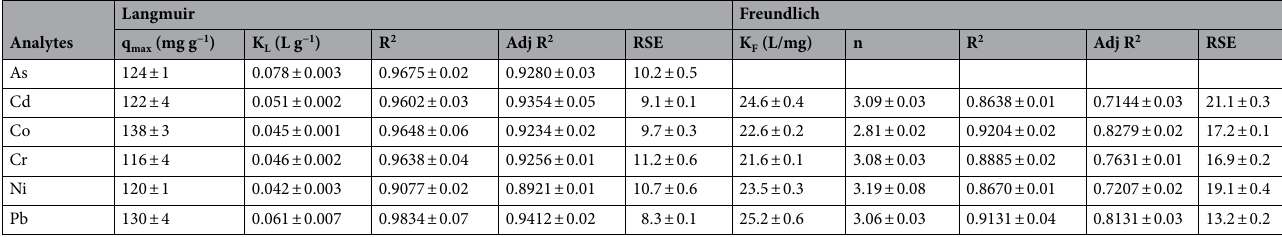
Table 1. Non-linear adjusted Langmuir and Freundlich isotherm